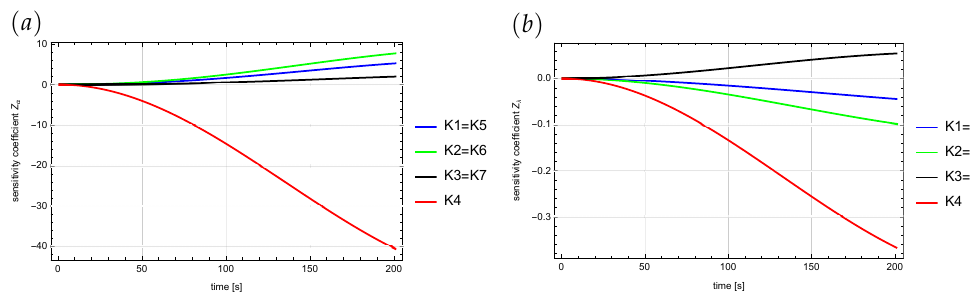
Figure 6. Sensitivity coefficient in measurement points along the time domain: ( a ) Z α , ( b ) Z λ